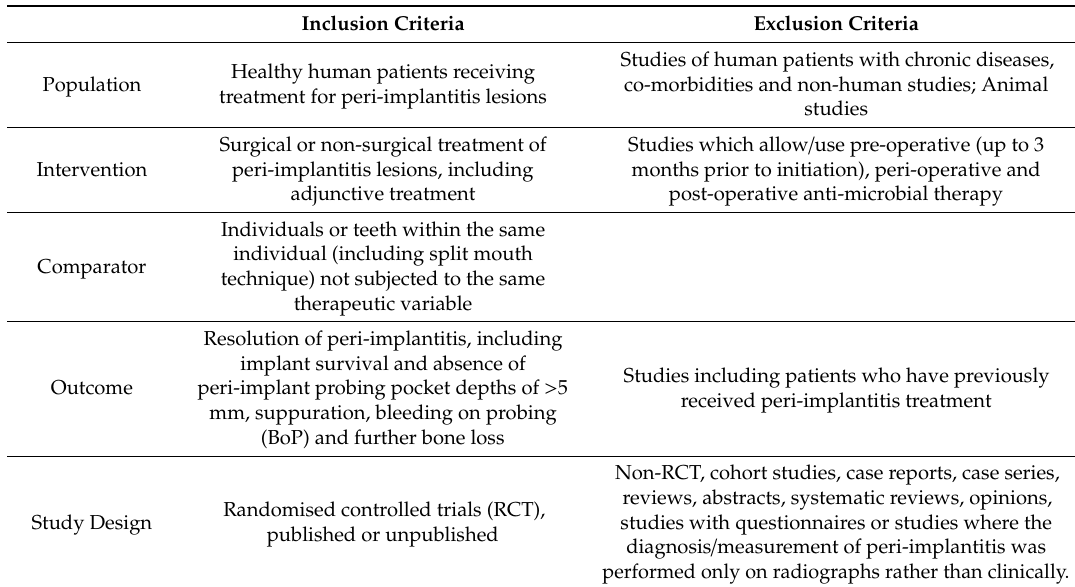
Table 2. Eligibility Criteria.